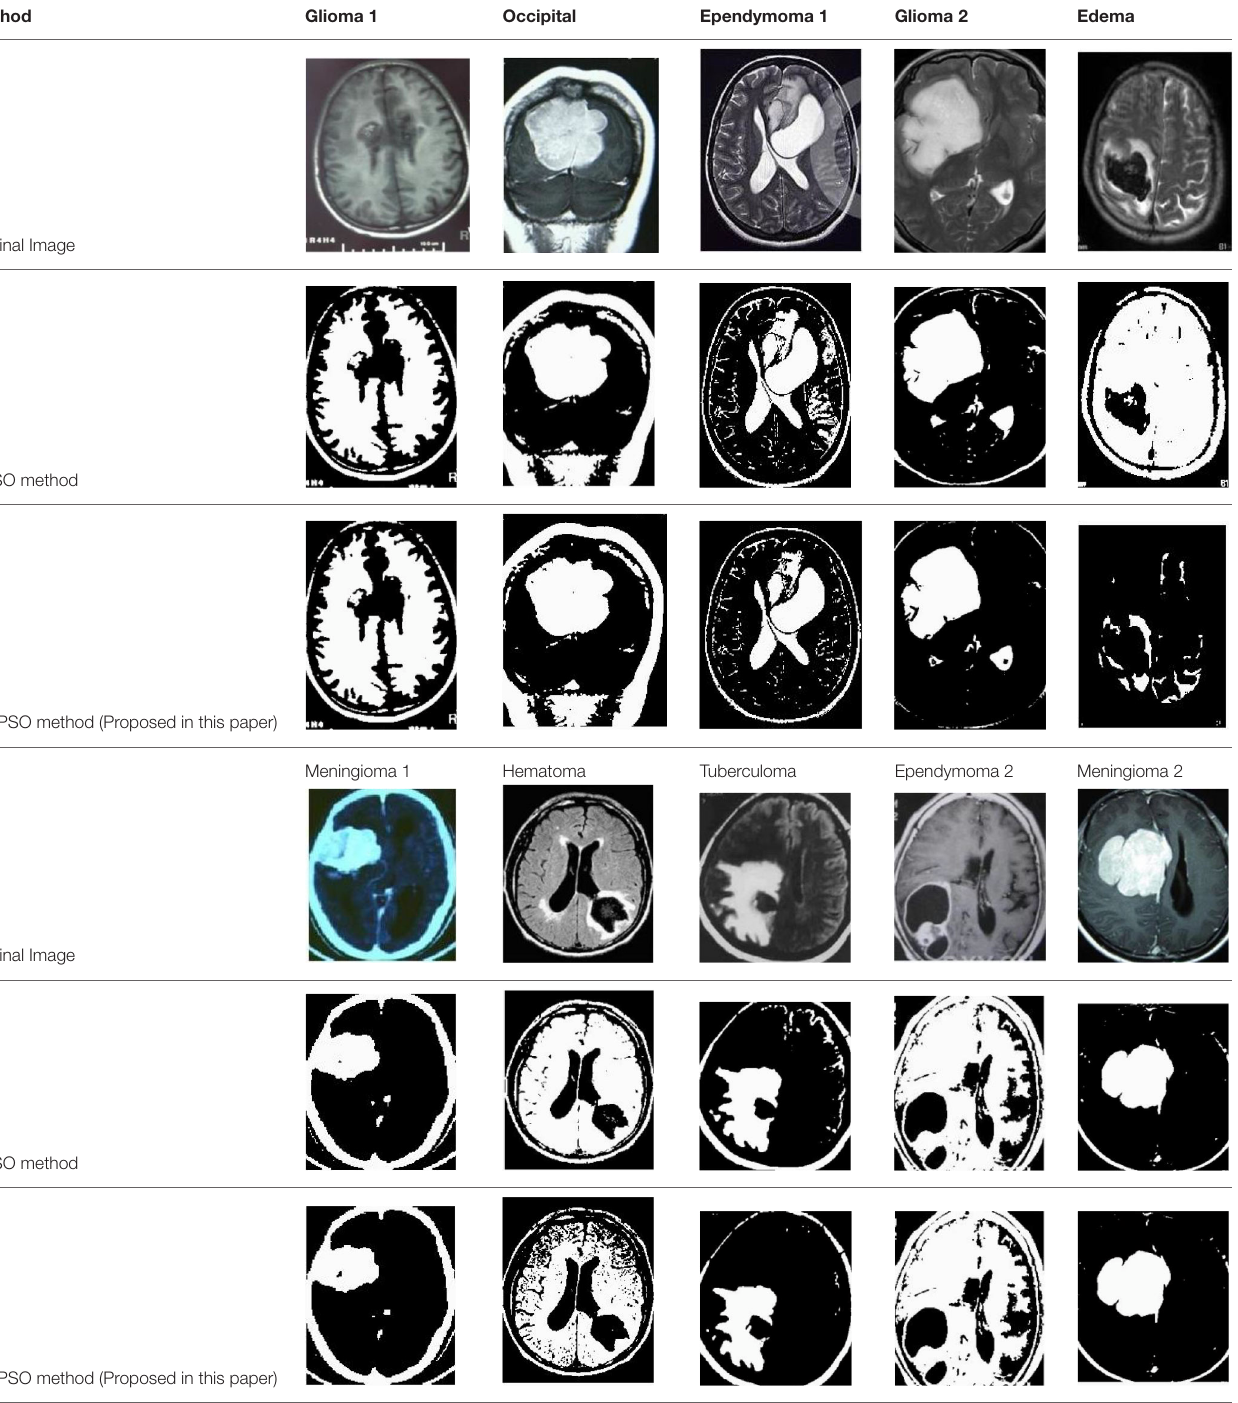
TABLE 1 | MRI brain image segmented by quantum-behaved particle swarm optimization (QPSO) and quantum and wormhole-behaved particle swarm optimization (QWPSO)